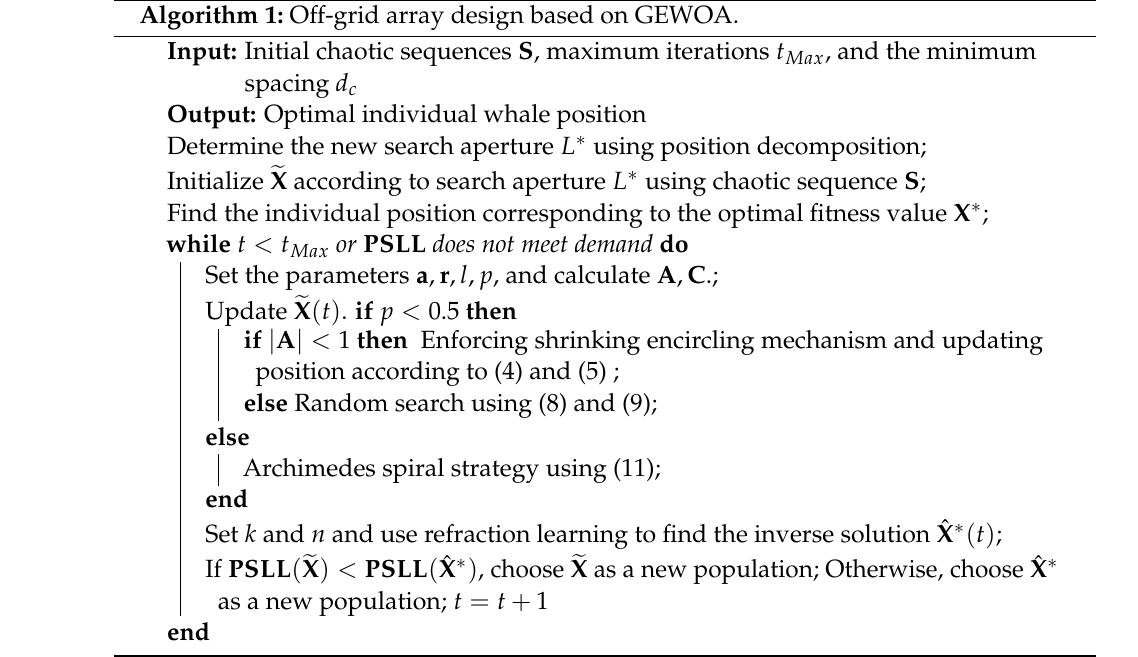
Algorithm 1: Off-grid array design based on GEWOA. spacing d